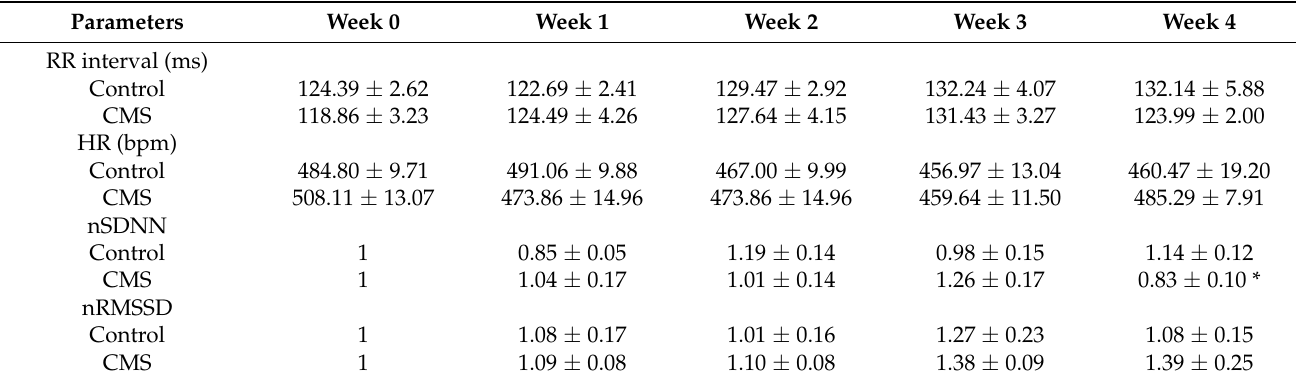
Table 2. RR interval, HR, normalized SDNN and RMSSD of control and CMS.